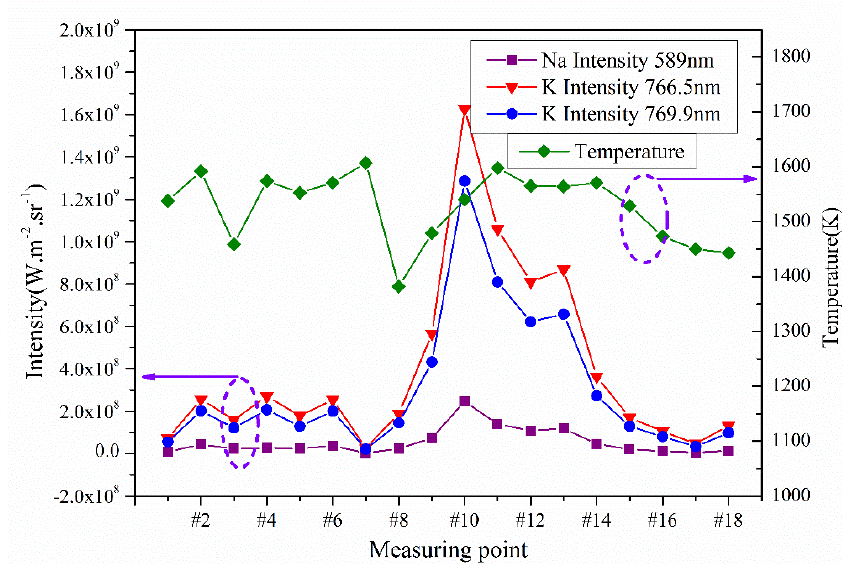
Figure 13. Relationship between actual radiation of alkali metal and calculated temperature at different measurement points.